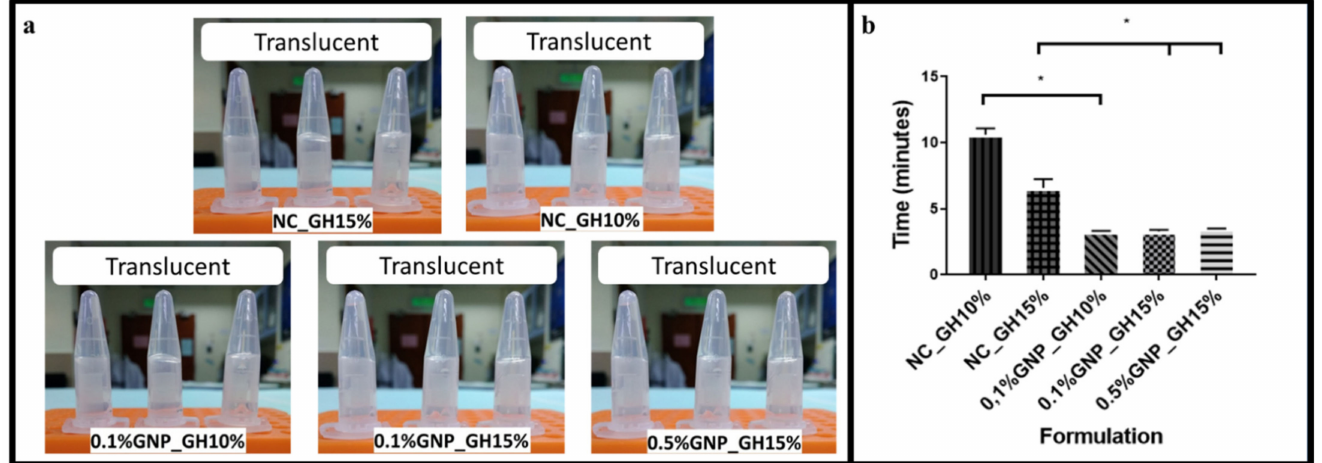
Figure 1. Optimisation phase. ( a ) All hydrogels appeared as a translucent system. ( b ) GNP_GH groups were polymerised within 3 min at room temperature (22–24 ◦ C). * represented significant difference ( p < 0.05, n = 3, N =